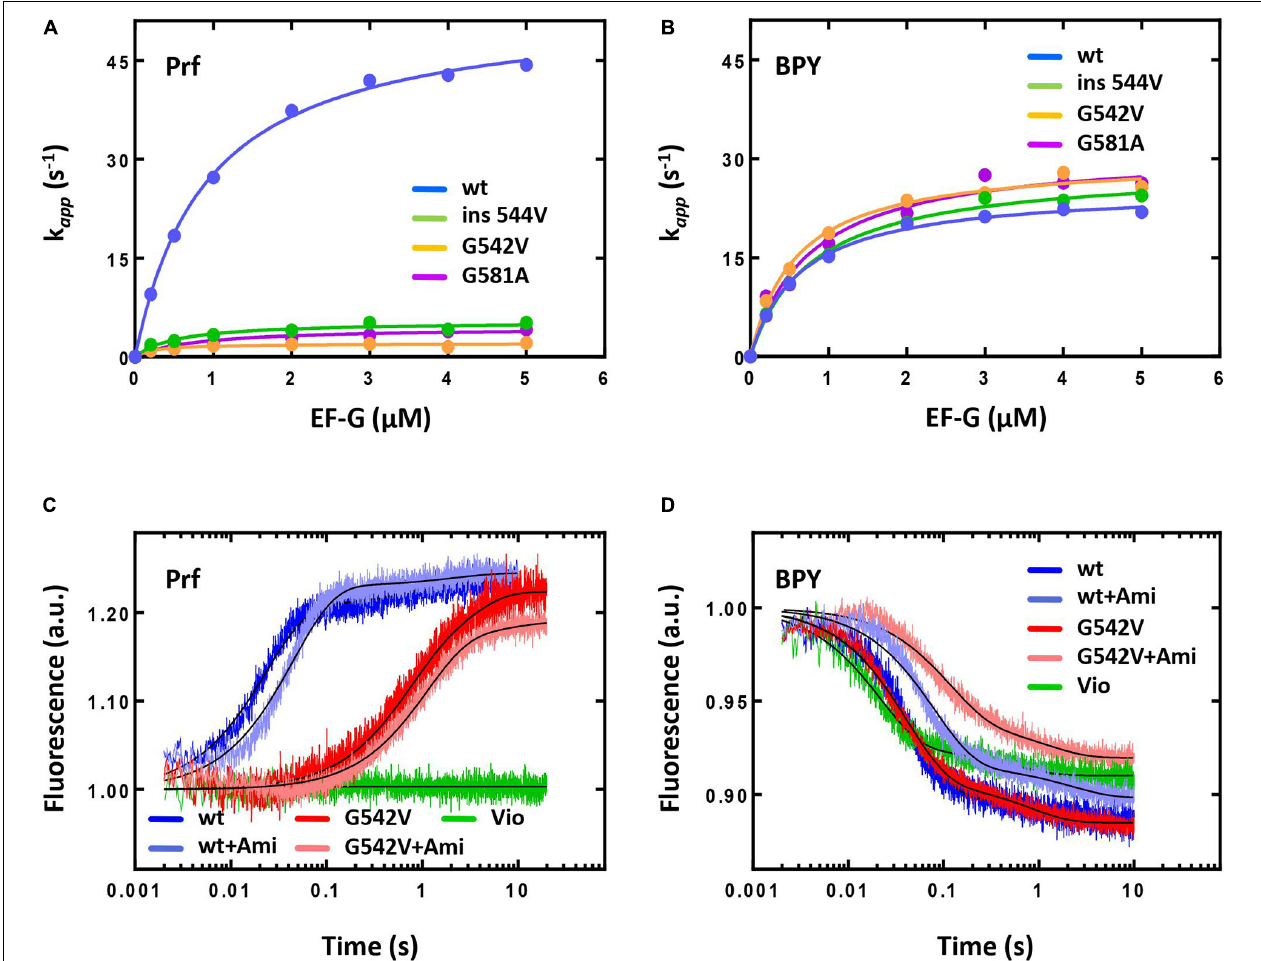
FIGURE 5 | The pre-steady state kinetics of translocation catalyzed by intact or mutant forms of EF-G. The dependence of the fast translocation phase rate on the concentration of EF-G monitored by the fluorescence change of fMet-Phe-tRNA Phe (Prf16/17) (A) or BPY-Met-Phe-tRNA Phe (B) . The time courses of single round translocation (at saturating concentration of EF-G (5 µ M) monitored by the fluorescence change of fMet-Phe-tRNA Phe (Prf16/17) (C) or BPY-Met-Phe-tRNA Phe (D) . Viomycin (Vio). Error bars (s.d.) in (A,B) were obtained from at least two independent experiments with 5–7 technical replicates each, however, do not exceed the size of